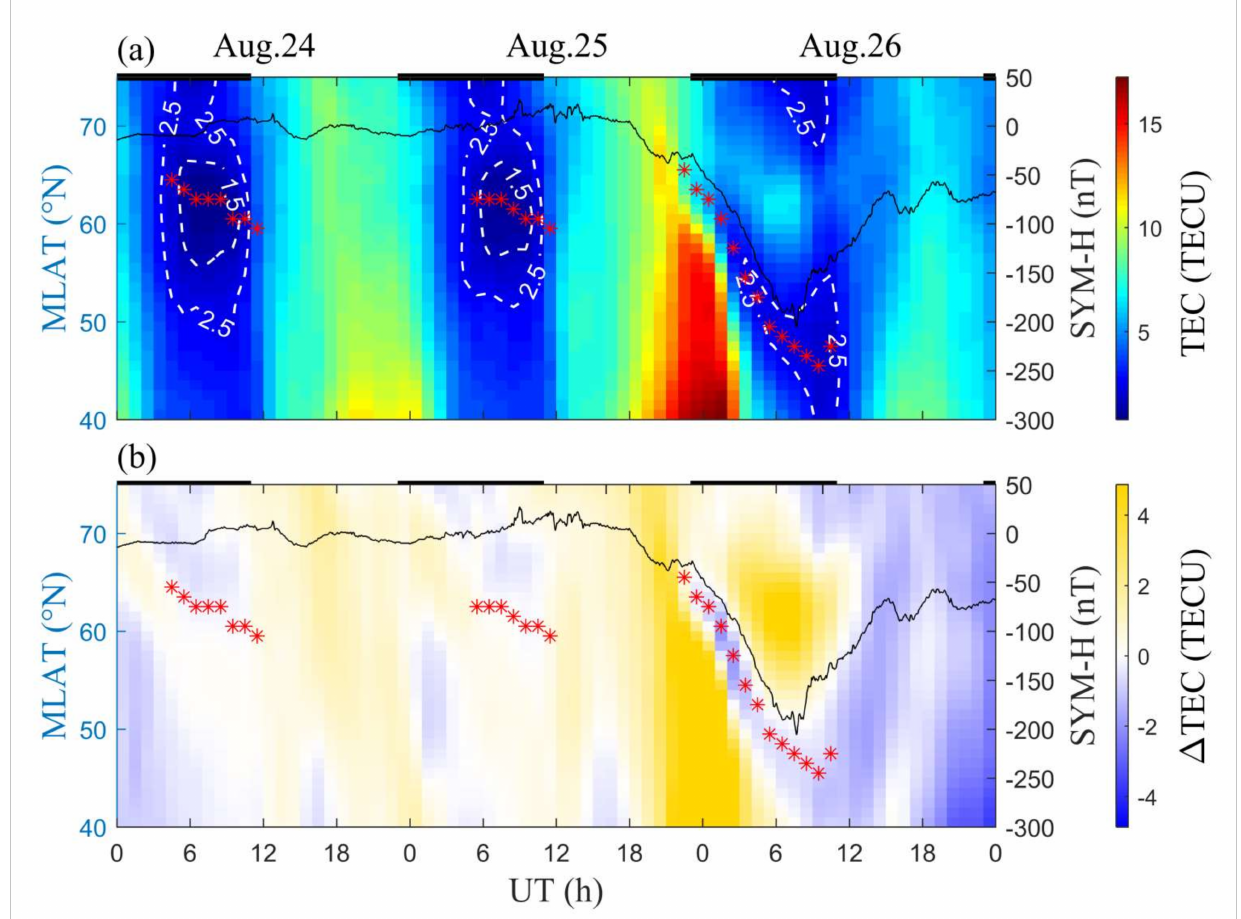
Figure 3. Ionospheric storm variations of ( a ) TEC and ( b ) TEC absolute deviations from the reference for the American sector during the 2018 August storm. The contour levels indicate the 1.5 and 2.5 TECU values. The red asterisks indicate the mid-latitude trough position. The black line shows the SYM-H variations. The local nighttime in the American sector is marked with thick black line